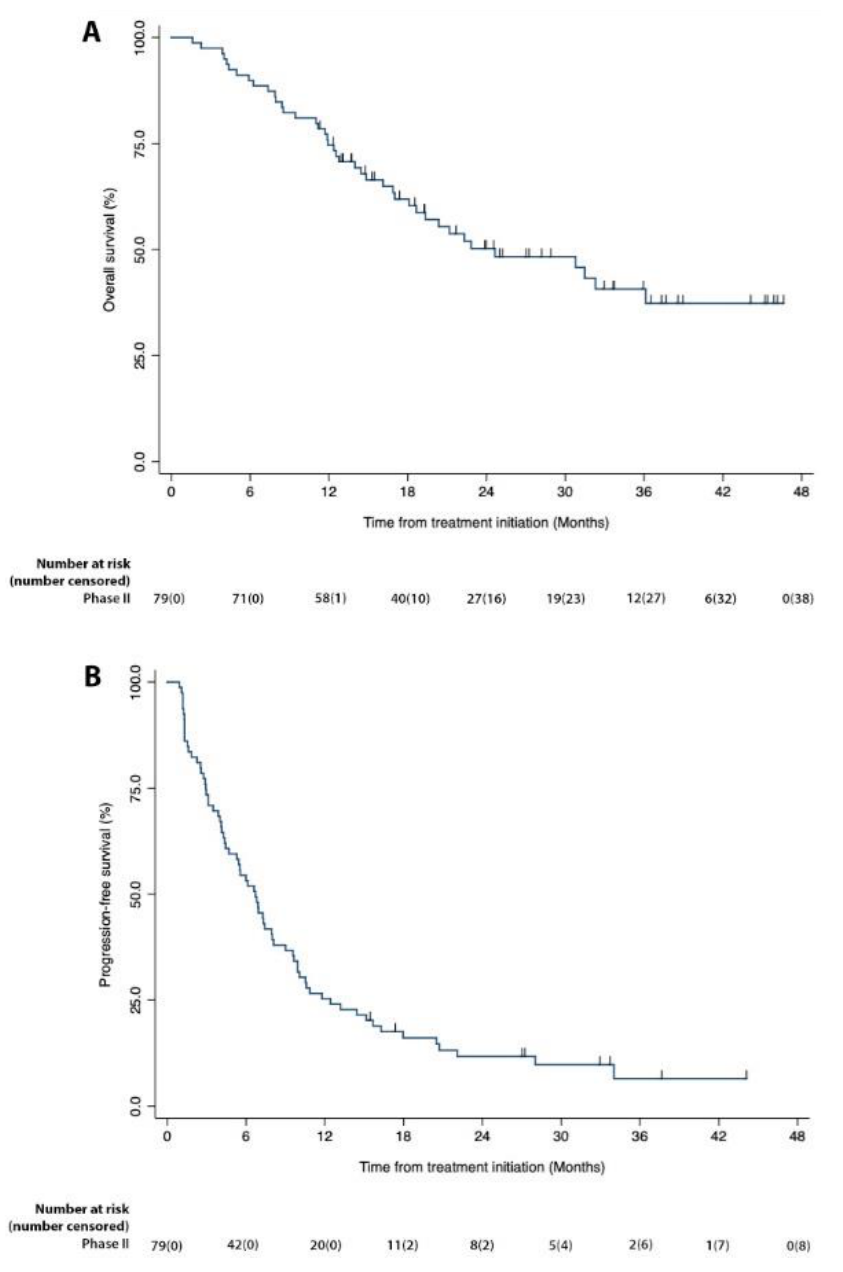
Figure 2. Kaplan–Meier graphs of overall survival and progression free survival for the mITT patients in Phase II of the study. ( A , B ) Percent survival is plotted on the vertical axis as a function of time from treatment initiation (months) plotted on the horizontal axis.